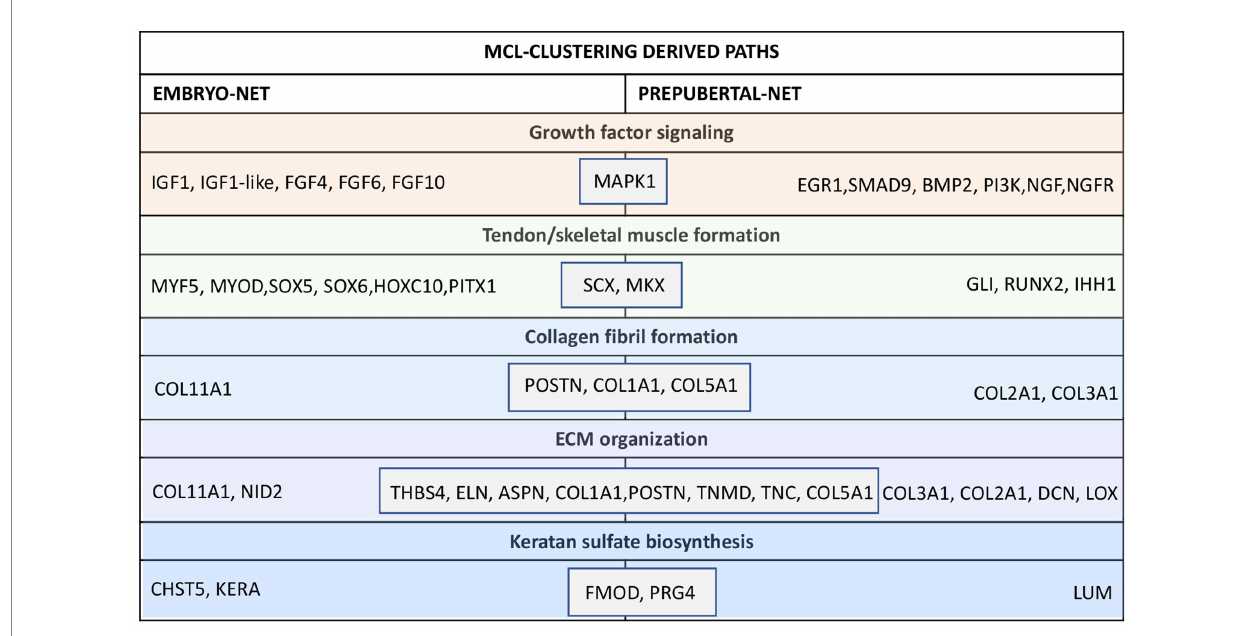
FIGURE 6 Nodes clustering of the mouse embryo and prepubertal TendonNETs. The table summarizes the results of clustering classified for MCL-recognized paths by indicating within the gray boxes the 13 shared nodes. In orange were reported nodes of the upstream layer, in green nodes of the TF layer, and in light blue nodes of the downstream layer.